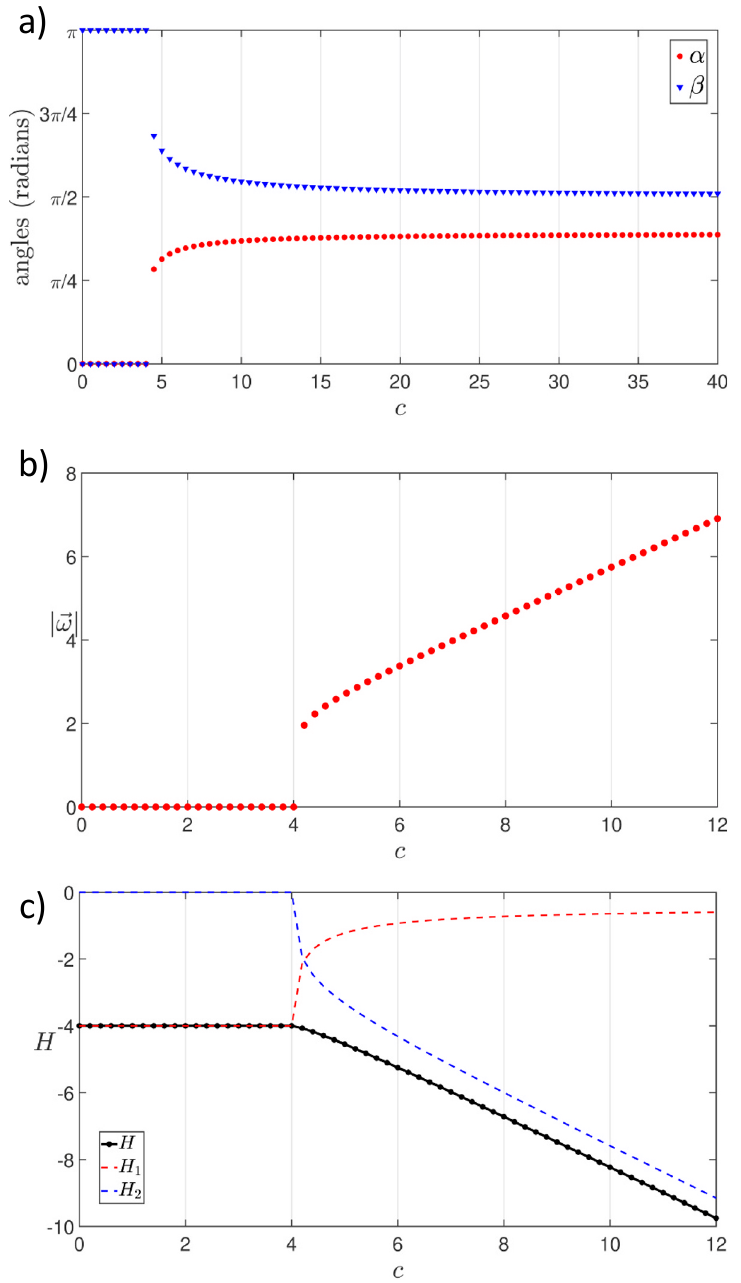
Figure 1 . Panel a) The minimum energy values of the angles (3.23) as a function of the parameter c in (3.22). The asymptotic large- c values ( (cid:11); (cid:12) ) = (arccos(1 = 3) ; (cid:25)= 2) correspond to a tetragonal disphenoid.Panel b) The angular velocity of the time crystal with Hamiltonian (3.22) as a function of the parameter c . Panel c) The total energy H and the individual contributions H 1 and H 2 in (3.22), as a function of parameter c for the time crystal.